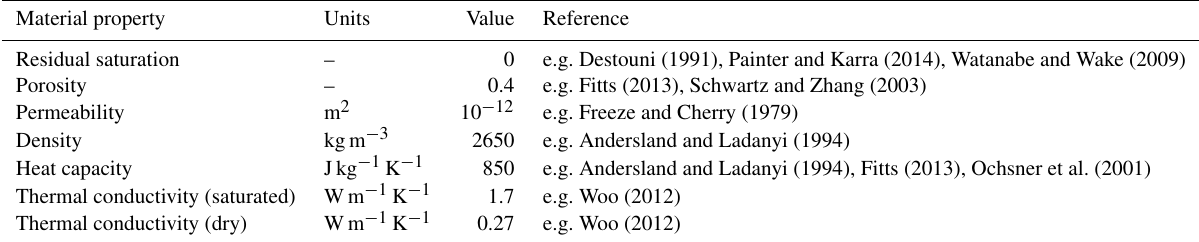
Table 3. Physical and thermal subsurface properties used in model simulations. Material property Units Value Reference Residual saturation –